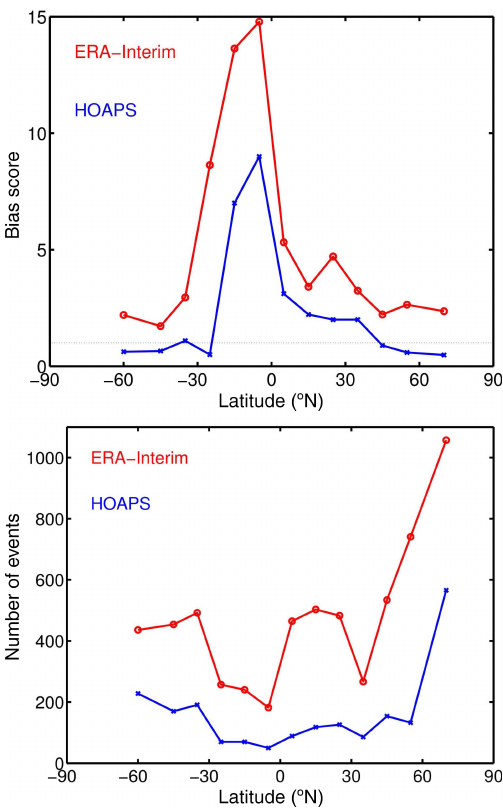
Figure 9. Bias score (top) and number of events (bottom) for the period 2005–2008 as a function of latitude (latitude belts are south of 50, 50–40, 40–30, 30–20, 20–10 and 10–0 ◦ S; 0–10, 10–20, 20– 30, 30–40, 40–50, 50–60 and north of 60 ◦ N) for HOAPS and ERA- Interim. A lower threshold is not set for ERA-Interim